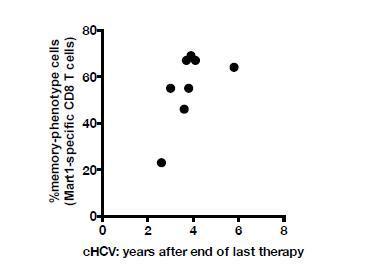
Percentages of MP cells within Mart1-specific population is not a function of delay post-treatment in cHCV patients.